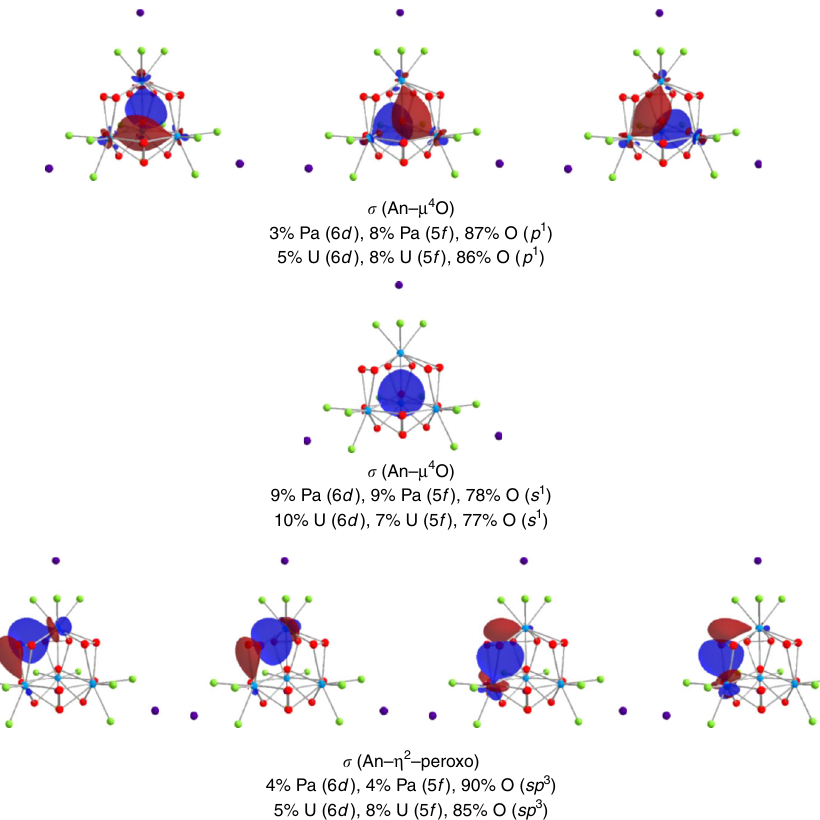
Fig. 3 Plots of the natural localized molecular orbitals of Cs 4 [An 4 O(O 2 ) 6 F 12 ] 2 − . This fi gure shows the four σ bonds to the central μ 4 – oxygen, the four σ - bonds between the actinide and the η 2 – peroxo bond. The atomic orbital contributions to the localized natural molecular orbitals are provided and highlight the increasing 5 f participation in moving from Pa to U. The isosurface cutoff is 0.03. The metal atoms are turquoise spheres, the oxygen in red, fl uorine in green, and the rubidium atoms in purple Table 3 Metal – oxygen bond distances and QTAIM characteristics of the [M 6 O 19 ] 8 – clusters Metal QC